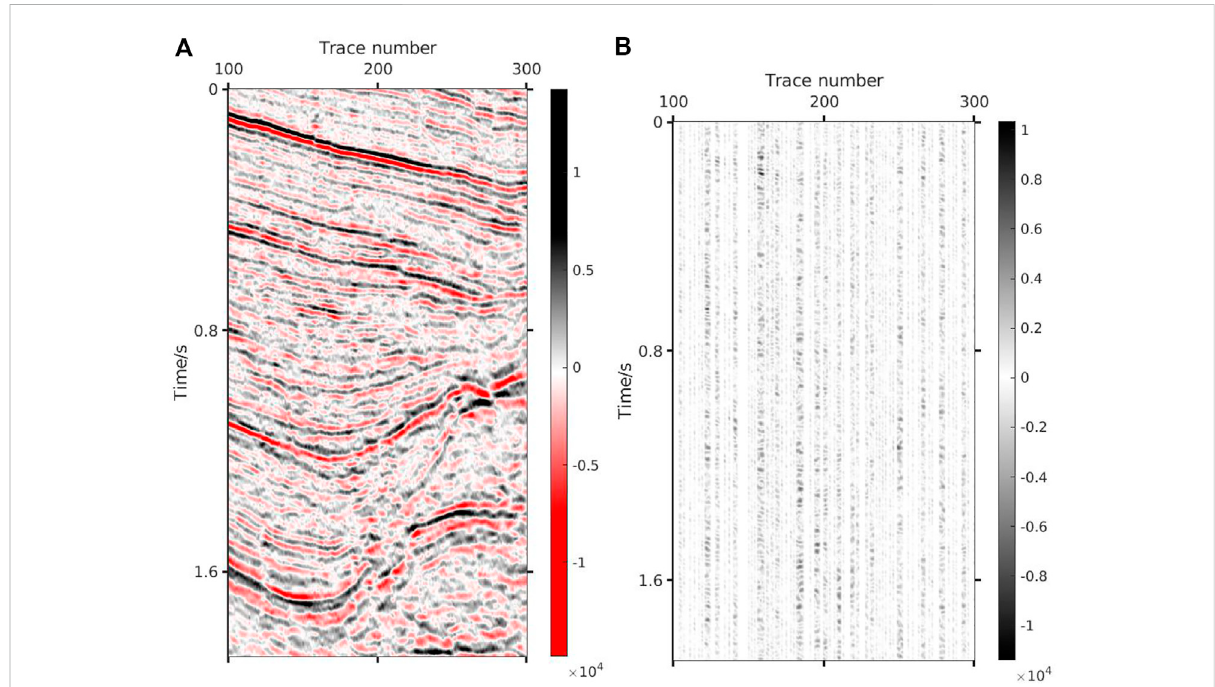
FIGURE 9 Result via Shearlet. (A) Result via Shearlet (SNR=7.59 dB PSNR=23.94 dB). (B) Absolute error via